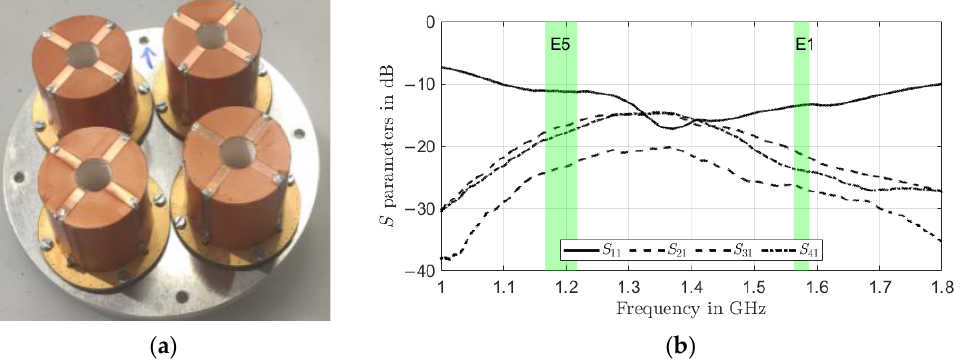
Figure 3. Miniaturized wideband GNSS antenna array. ( a ) Array configuration from individual annular ring dielectric resonator antennas in 2 × 2 quadratic configuration; ( b ) Measurement of scattering parameters between array elements showing a reflection coefficient below − 10 dB for the embedded element and a maximum mutual coupling of − 15 dB between neighboring array elements. Besides a satisfying S11 of < − 10 dB of the embedded elements over all GNSS fre-